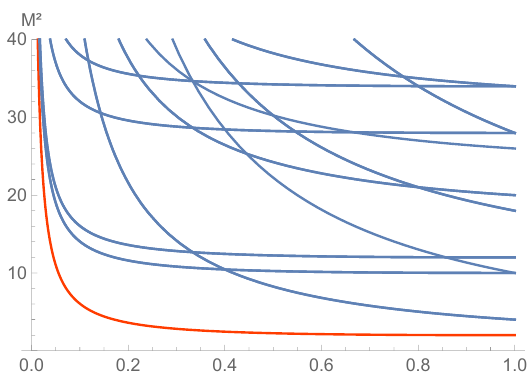
The mass squared M 2 (in string units (cid:11) 0 = 1) of dark matter candidates with constructing element ( 1 ; (cid:28) ) S and various KK numbers 5 m i 5 for i = 1 ; 2 (and m 3 = 1) 2 (cid:0) (cid:20) (cid:20) depending on the compacti(cid:12)cation radius r = ( R 2 ) 2 . The lightest (cid:28) -winding string state (in red) is speci(cid:12)ed by n = (0 ; 0 ; 1) T and m = (0 ; 1 ; 1) T . In this (cid:12)gure, the other moduli parameters are set according to eqs. (A.15) and (A.16), where the mediator is massless independently of r = ( R 2 ) 2 . of the mediator are much smaller than